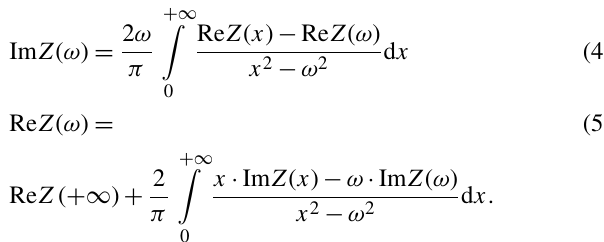
voltage drop across the SUT is measured (of course, the impedance being still given by Eq.